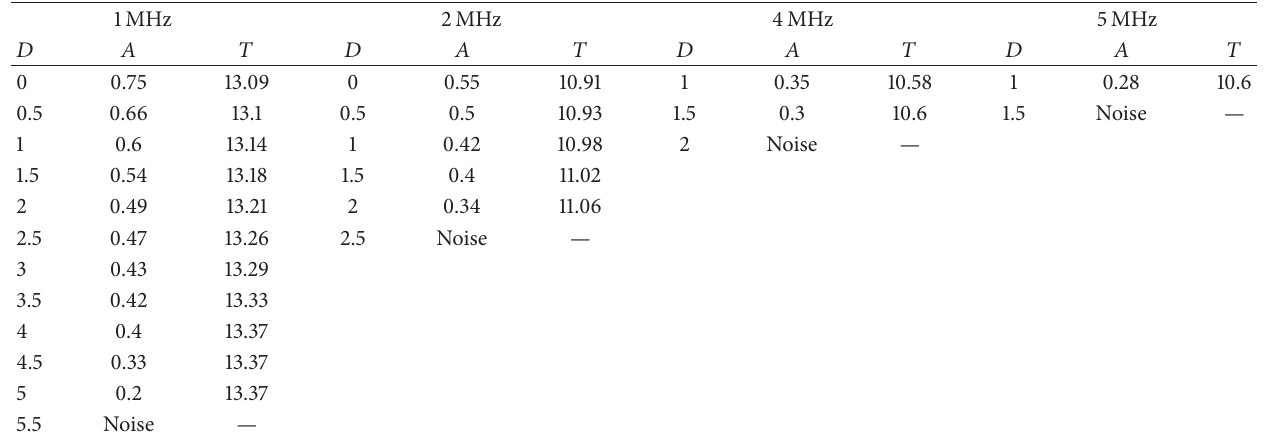
Table 1: The results of L CR depth measurement.